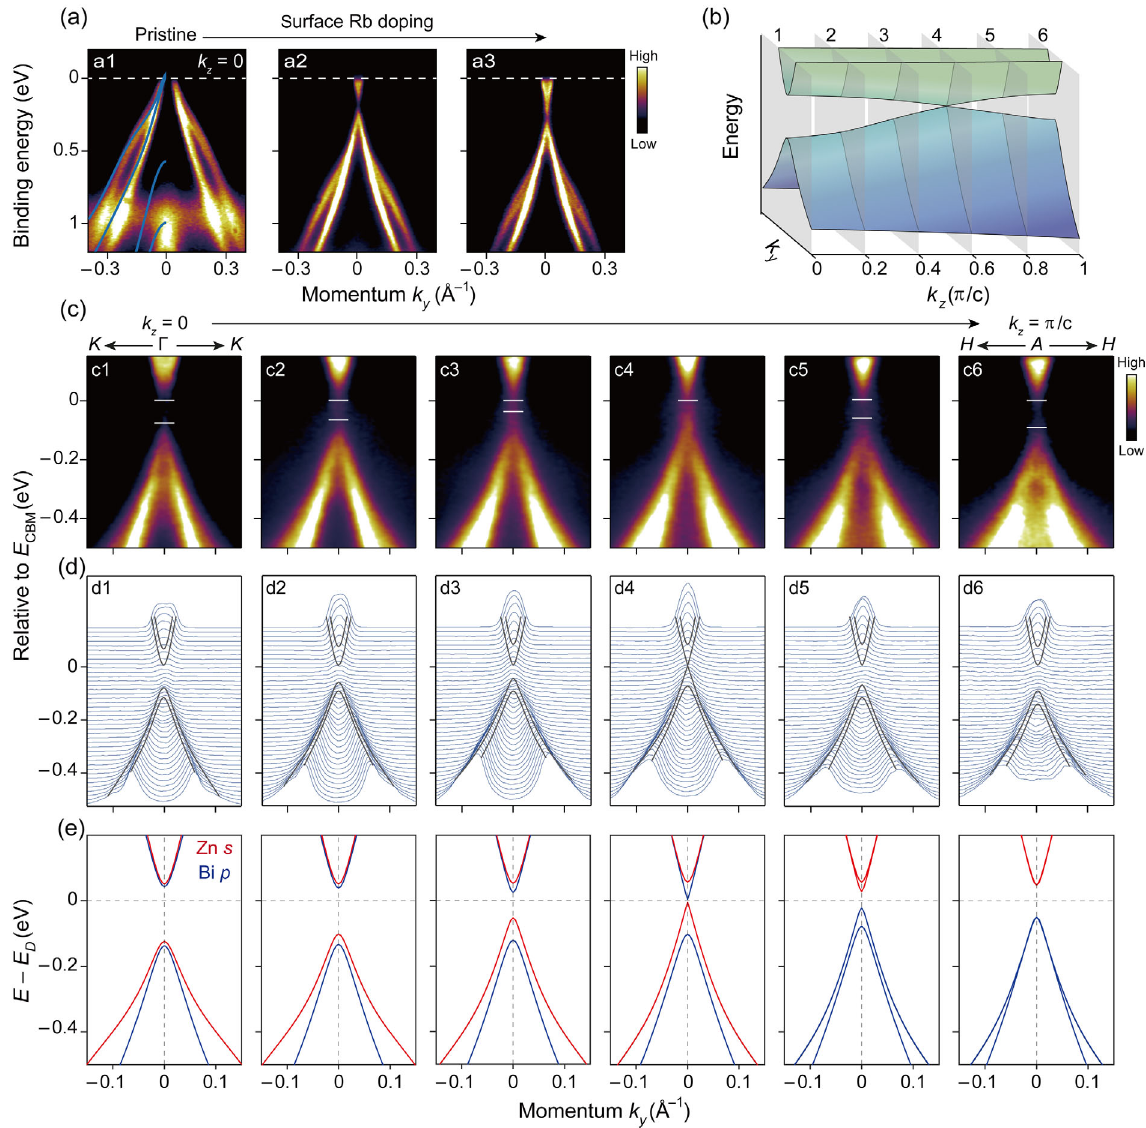
FIG. 3. Direct observation of 3D Dirac fermions from angle-resolved photoemission spectroscopy (ARPES). (a) ARPES spectra of the ¼ 0 (a1). The overlaid blue solid lines show the calculated band structure. E pristine sample along the Γ -K direction at k is rising with z F surface Rb doping and the conduction band appears [(a2) and (a3)]. (b) Schematic of 3D Dirac cone with slices (gray planes) at different positions of k . (c) Measured band dispersions after surface Rb doping along the k direction at different k positions from 0 to π =c [(c1) z y z − (c6)]. The k positions of each panel correspond to those presented in (b) and are numbered accordingly. White lines represent the z conduction band minima (CBM) and valance band maxima (VBM). The CBM energy in each panel was set to 0 eVafter subtracting the Rb impurity level. (d) Stacked MDCs of (c). Overlaid gray solid lines are guidelines for the band dispersion. (e) Calculated band dispersions at k positions corresponding to (c) and (d). The red and blue solid lines represent Zn s and Bi p orbitals, z